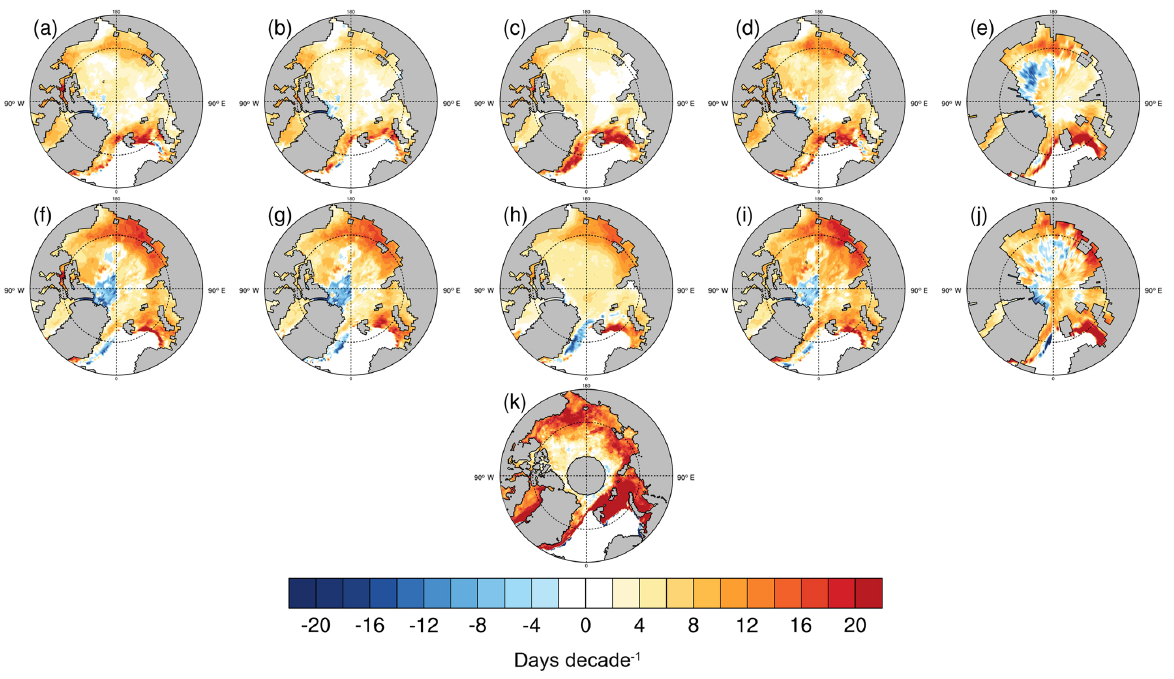
Figure 9. Trend in melt season length over 1979–2014 for each CESM LE definition in the two members where they are available (member 34 in a–e , member 35 in f–j ) as well as in the PMW satellite observations (k) . The congelation–snowmelt definition is shown in (a) and (f) , the frazil–snowmelt definition in (b) and (g) , the volume–volume definition in (c) and (h) , the temperature–snowmelt definition in (d) and (i) and the temperature–temperature definition in (e) and (j) .